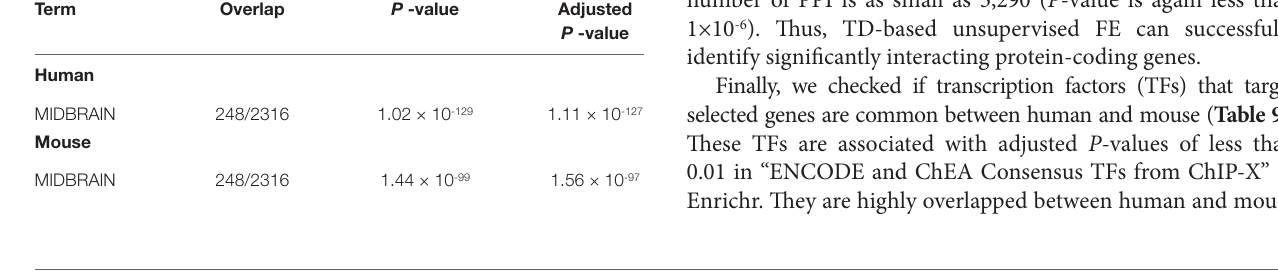
TABLE 7 | Five top-ranked terms from “GTEx Tissue Sample Gene Expression Profiles up” by Enrichr for selected 456 human genes and 505 mouse genes. Brain- related terms are asterisked. Human